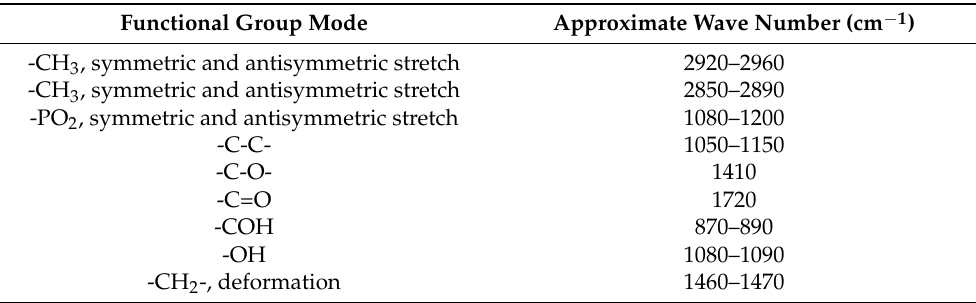
Table 3. Common vibrational